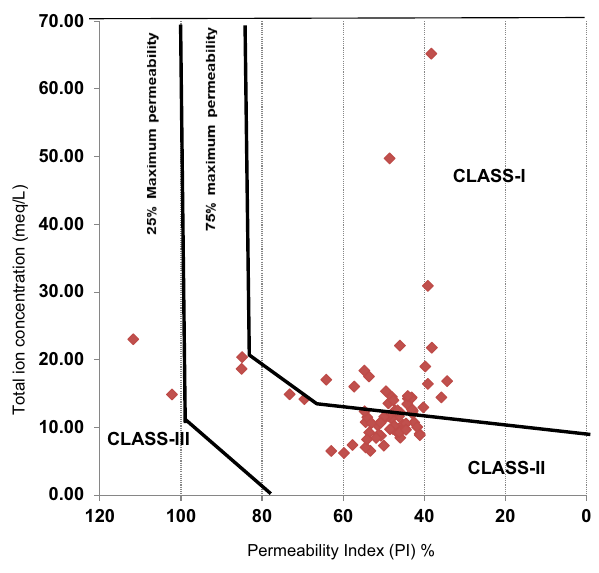
Fig. 8 Showing the Doneen’s classification for irrigation water based on permeability